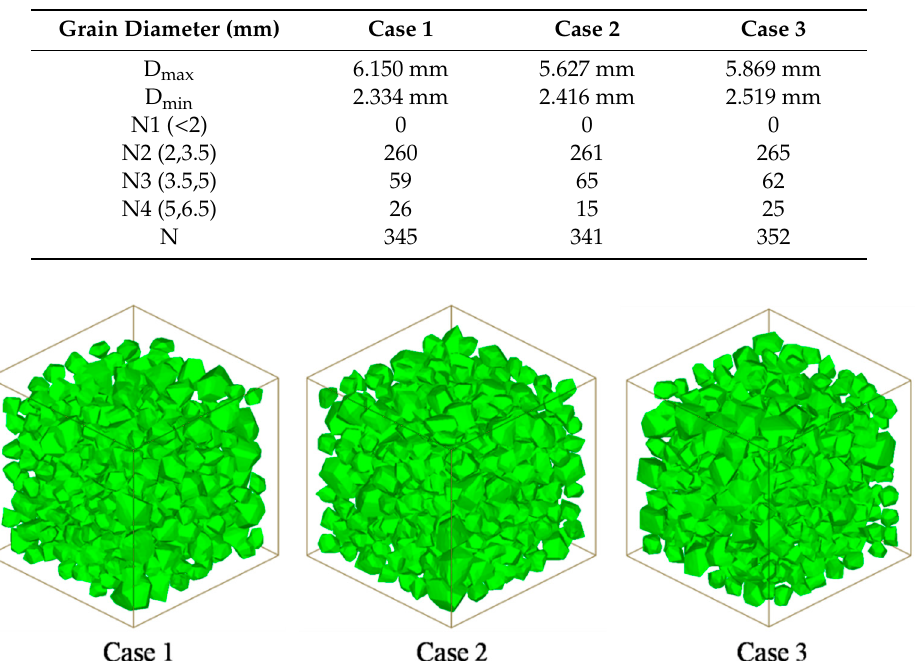
Table 4. Concrete mix proportions.